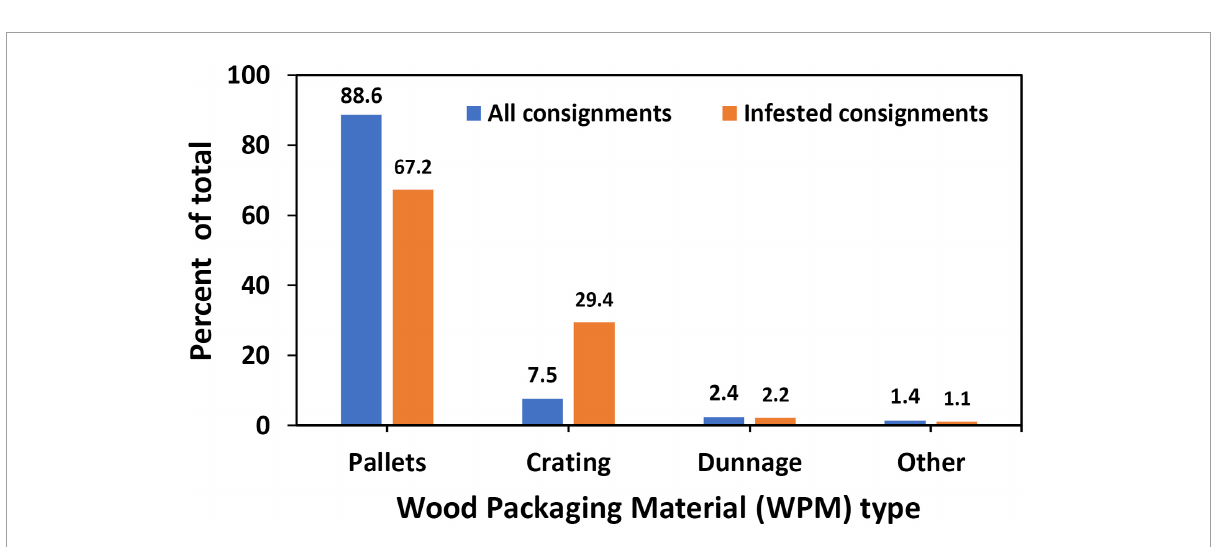
FIGURE4 Percentage of all consignments with WPM in the final dataset by the type of WPM inspected ( N = 87,571), and percentage of all 180 consignments in which wood borers were found by WPM type. Other refers to WPM items such as wood blocks and